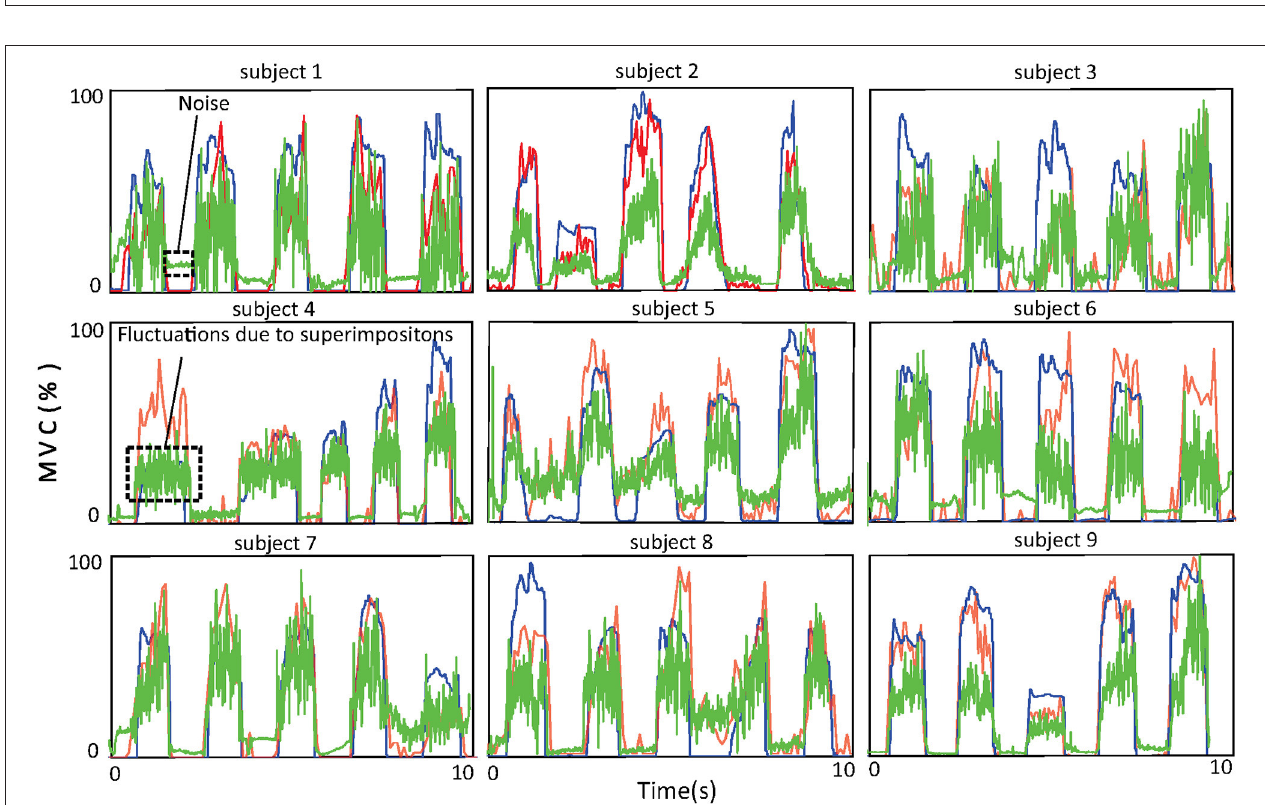
FIGURE 7 | Force curves for the nine subjects. The blue curves show the force recorded by the tensiometer, the red curves the force estimated by the proposed approach, and the green curves the force estimated from the amplitude of the sEMG signal.